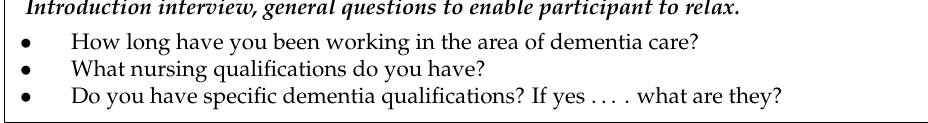
Table 1. Interview